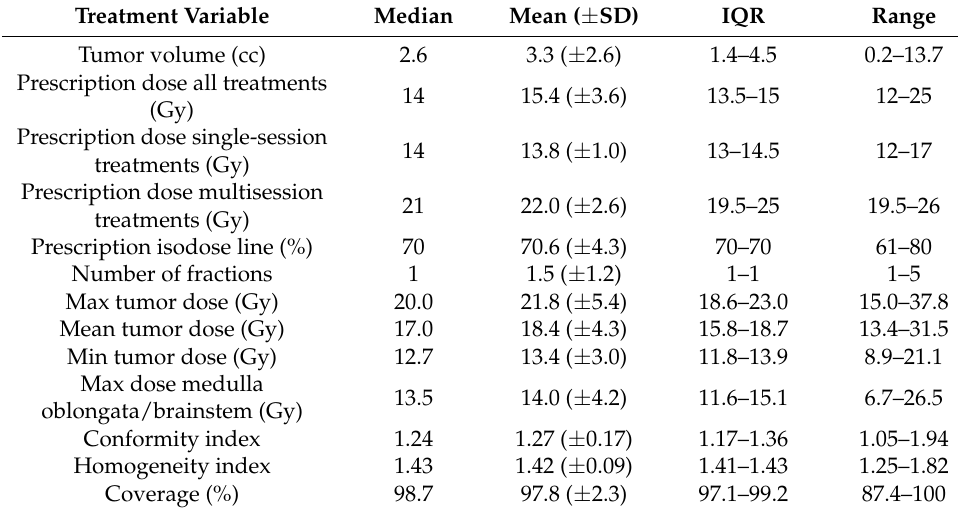
Table 3. Treatment